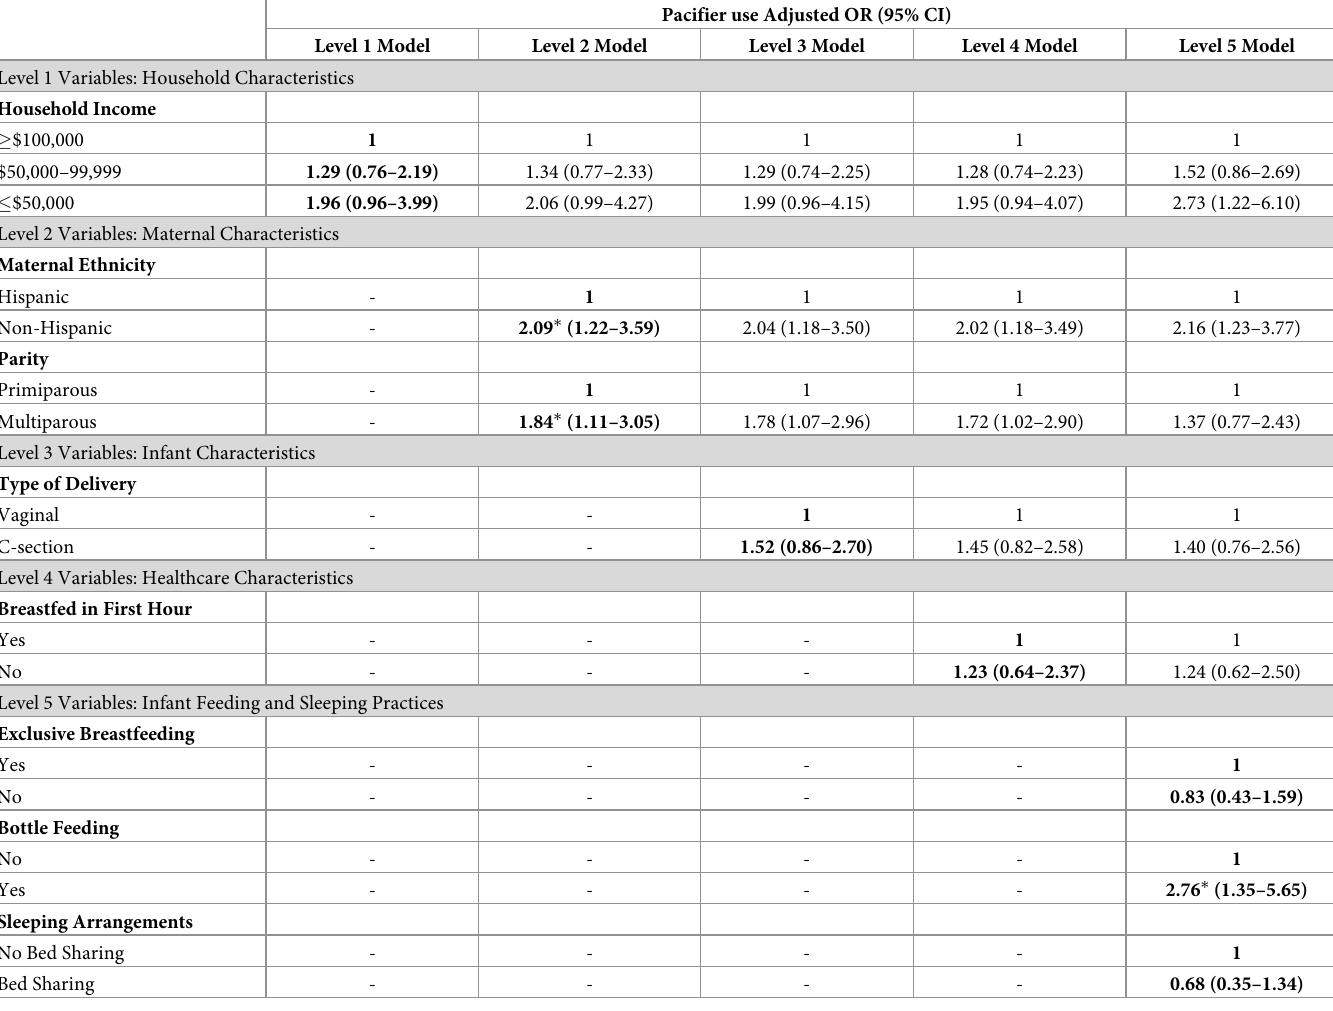
Table 4. Hierarchical logistic regression on the association between pacifier use and household, maternal, infant, and health care characteristics as well as infant feeding and sleeping practices, 2021. Each model level represents the addition of blocks of model variables as specified. A value of “1” across rows indicates the compari- son group in the model categorical